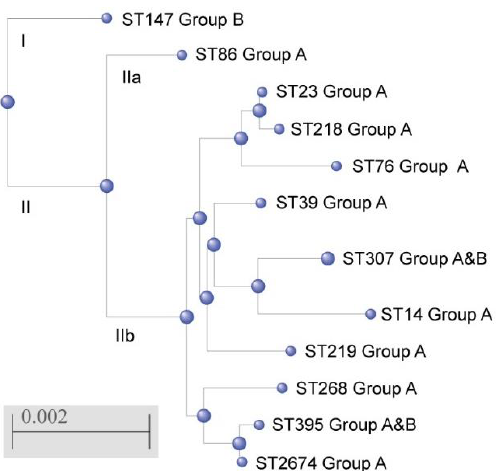
Figure 2. Phylogenetic tree of K. pneumoniae sequence types identified in the study generated by using a web resource NCBI “Blastn” and “Blast Tree View”, based on combined gene sequences of MLST profiles.